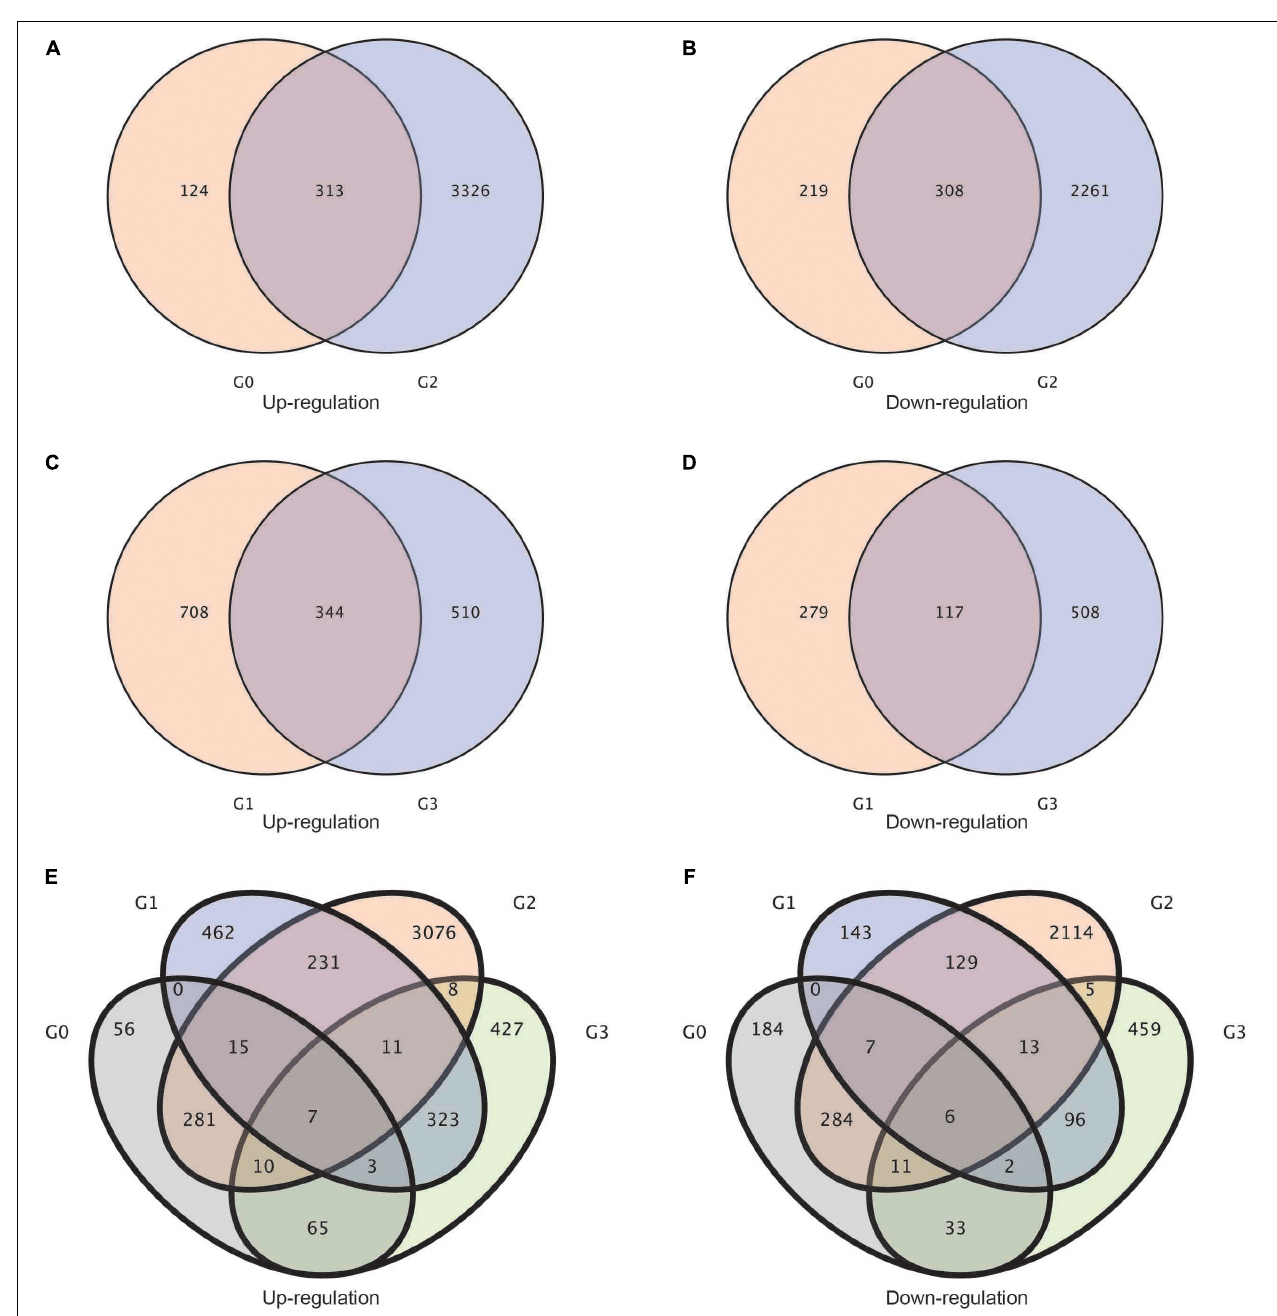
FIGURE 2 | Statistics of the common genes and specific genes in different groups. (A,B) Venn diagram of up-/downregulated differentially expressed genes between G2 and G0 groups. (C,D) Venn diagram of up-/downregulated differentially expressed genes between G3 and G1 groups. (E,F) Venn diagram of up/downregulated differentially expressed genes in all groups. G0: BcL.2-25 vs. BcL.2-4 ; G1: BcL.1-25 vs. BcL.2-25 ; G2: BcL.1-25 vs. BcL.1-4 ; G3: BcL.1-4 vs. BcL.2-4 .